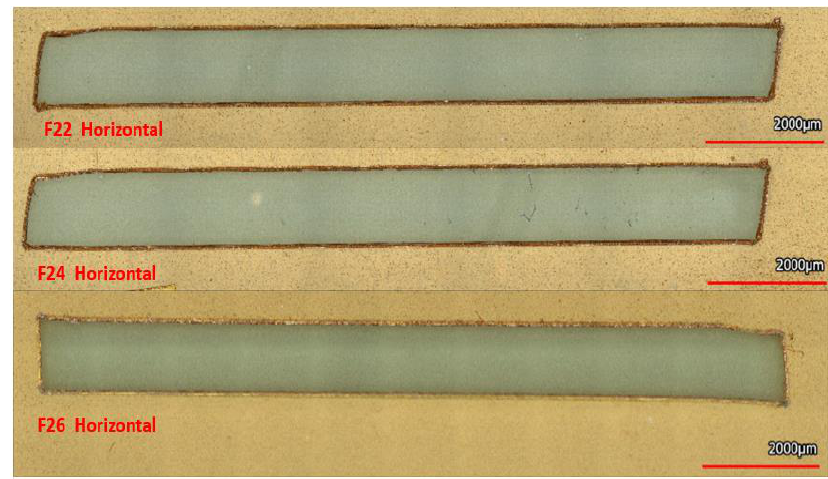
Figure 2. Laser confocal scanning images of the AutoBlade from the plotter cutter showcasing ellip- soidal curvature on the left and tip dimensions on the right. The blade characterization helps with assessment of cutting features on specific materials.